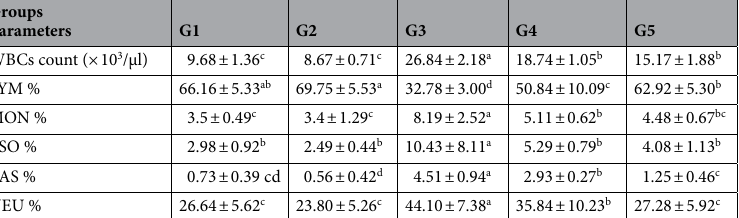
Table 3. Effect of thymoquinone supplementation and/or malathion inhalation on leukogram of rats. Values are expressed as mean ± standard errors. Means in the same row (a-b) with different subscript letters significantly differ at (p ≤ 0.05). WBCs white blood cells, LYM lymphocyte, MON monocyte, ESO eosinophil, BAS basophil, NEU neutrophil. G1 = control group, G2 = thymoquinone group (50 mg/kg body weight), G3 = malathion group G4 = malathion inhalation + thymoquinone 25 mg/kg body weight, and G5 = malathion inhalation + thymoquinone 50 mg/kg body weight.